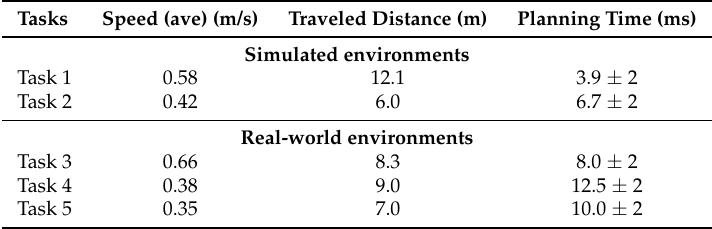
Table 3. Statistics of the speed, distance, and planning time during the